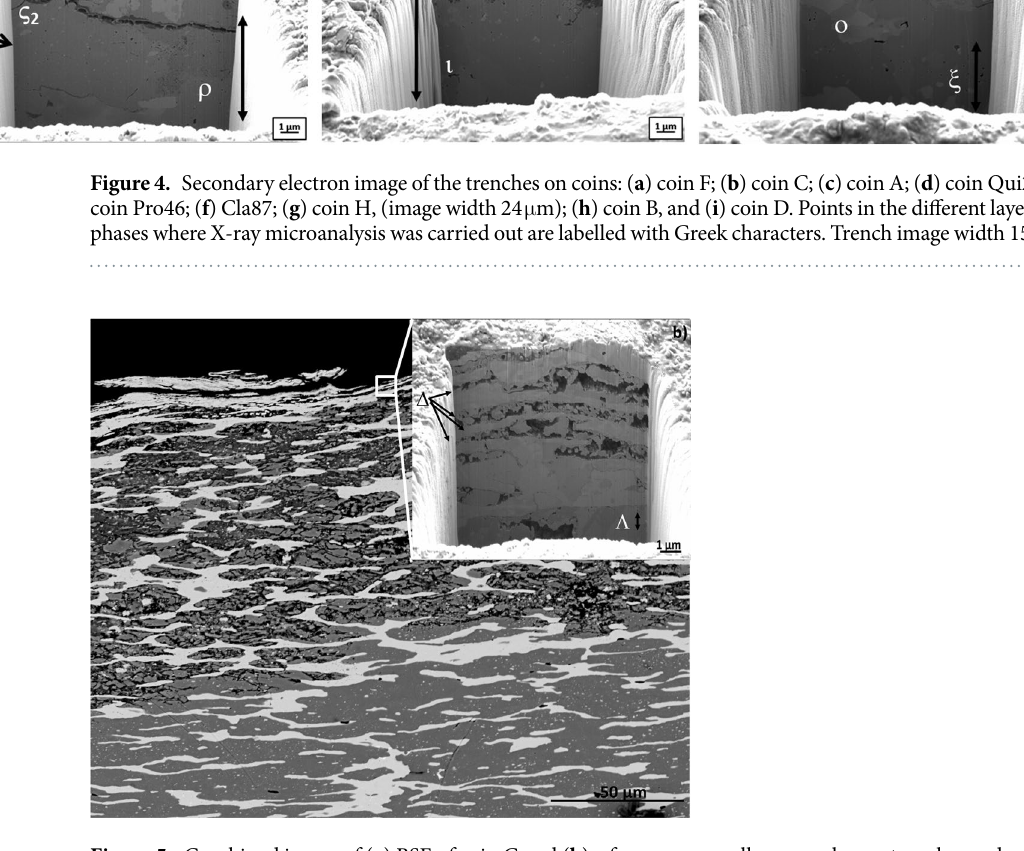
The quantitative EMPA and FIB-FESEM-EDX analyses support the hypothesis that Romans used the Cu-Ag alloys for the production of both the external layers and inner blanks not only during flourishing years but also during crisis periods contrarily to the traditional idea that they used Cu-Ag alloys during decadence periods to produce, exclusively, the external layers for lowering production costs. It is possible to suppose that the silvering